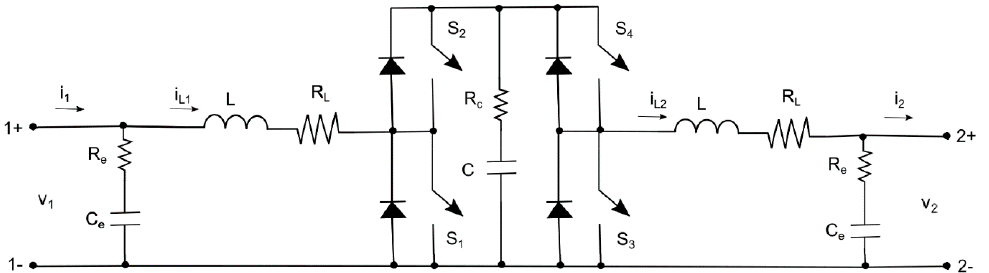
Figure 1. Schematic of the Split − pi converter. Table 2. Main parameters of the Split-pi converter.